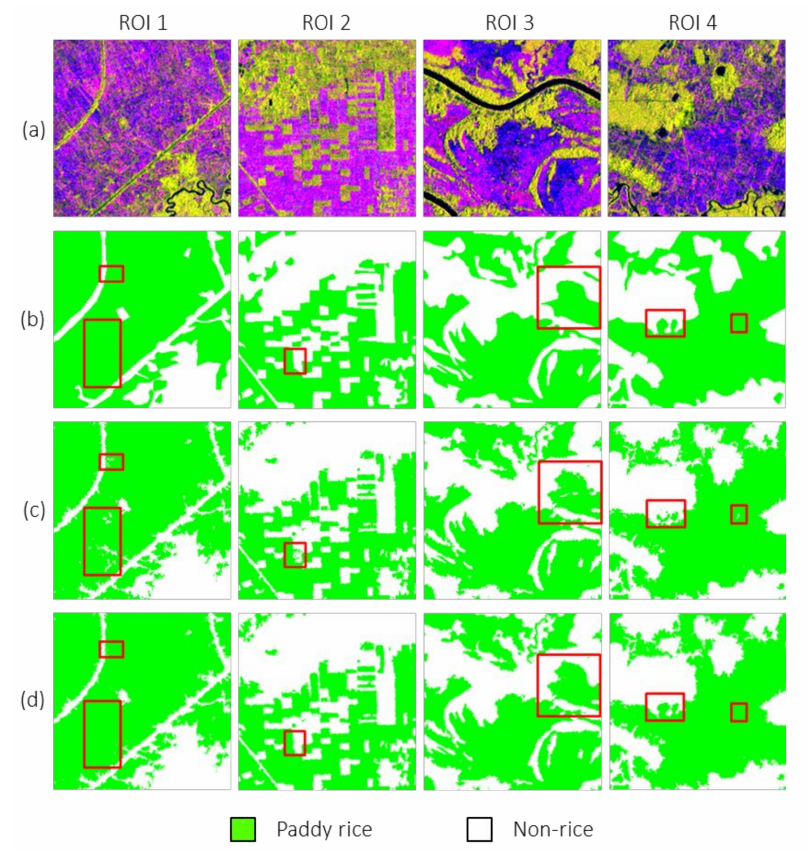
Figure 25. Comparisons between the paddy rice mapping results with and without fully connected CRF: row( a ) temporal feature image; row( b ) labels of row( a ); row( c ) paddy rice mapping results without fully connected CRF; row( d ) paddy rice mapping results of the proposed